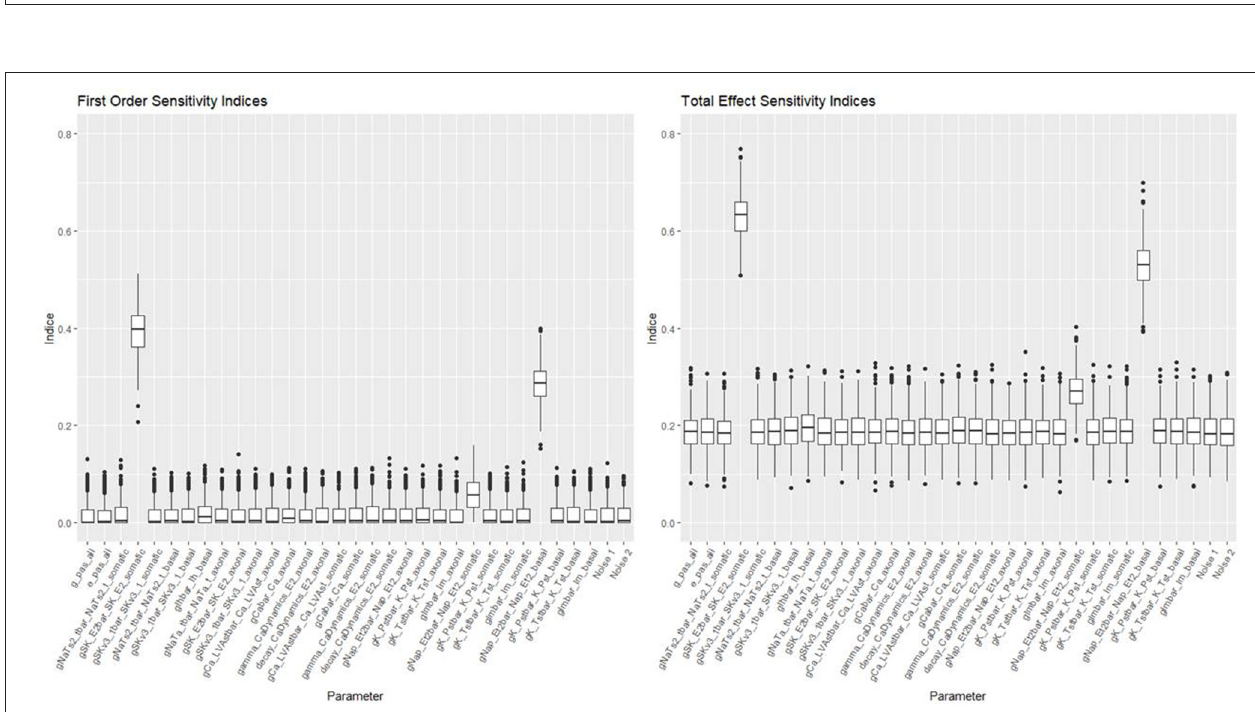
FIGURE 10 | Sensitivity indices for each input factor in emulating AP amplitude. The panel on the left shows first-order indices, and the panel on the right shows total effect indices. The last two factors on the right are randomly added “noise factors,” which indicate what might be expected for a factor that, by design, has no impact at all on the feature.